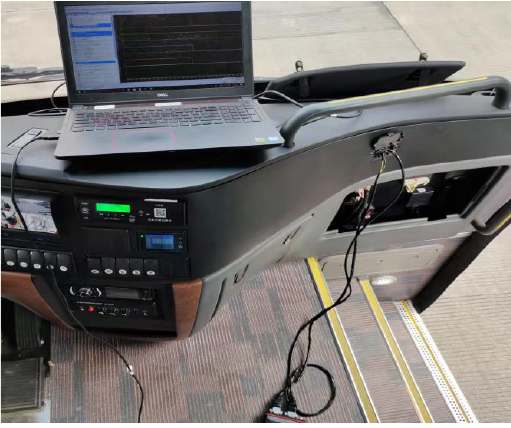
Figure 6. Real-world driving cycle